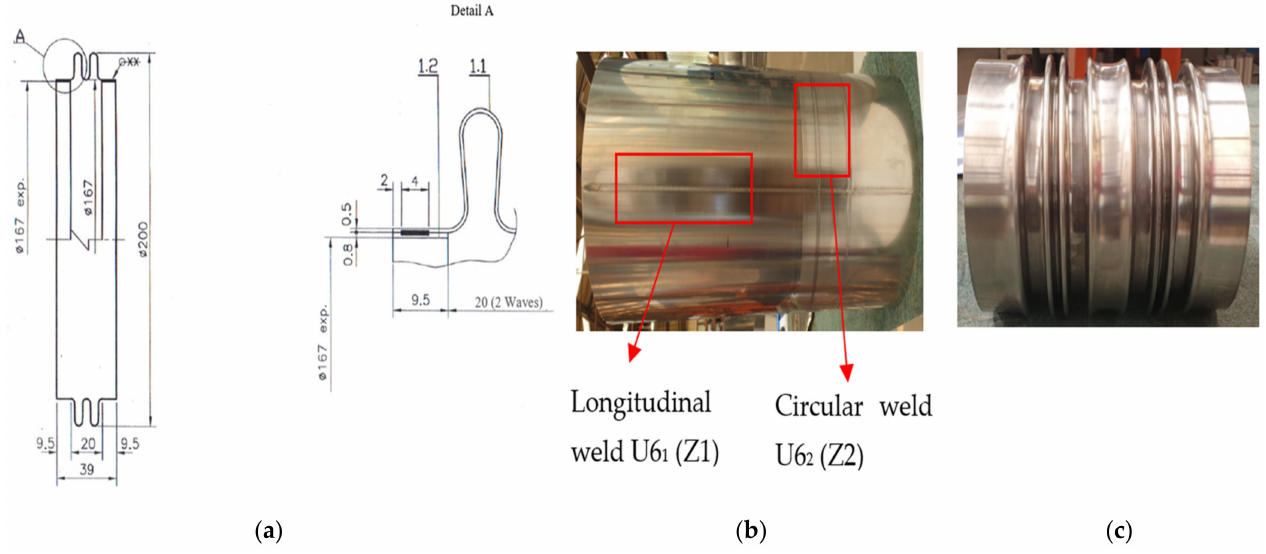
Figure 3. Preparation of the sample U6: ( a ) design for preparation of the bellows with the weld details, ( b ) appearance of the welded bellows, ( c ) formed